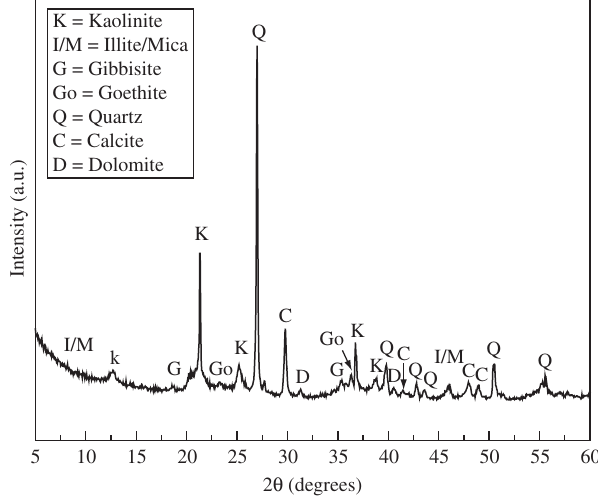
Figure 2. X-ray diffraction pattern of the ceramic paste.